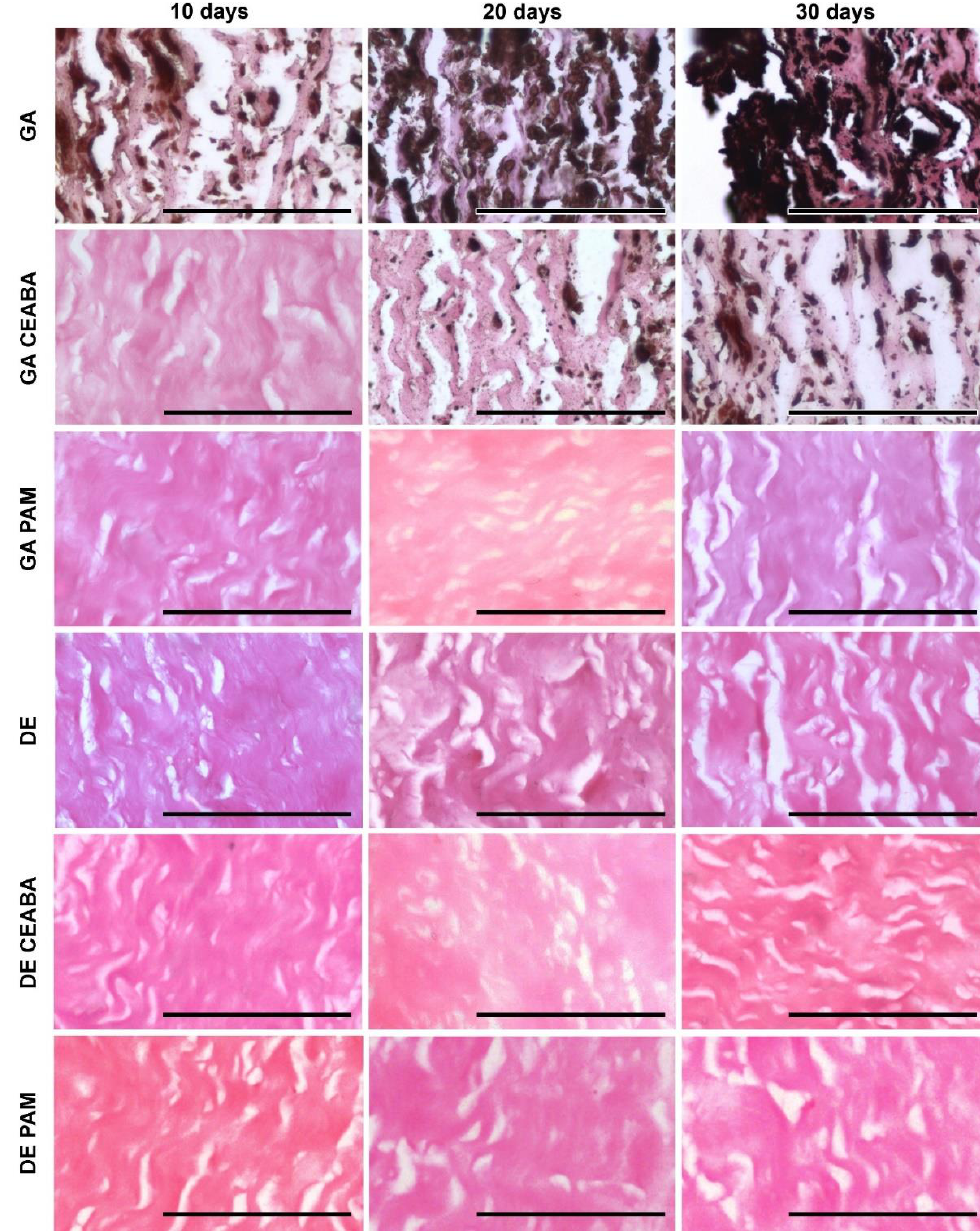
Figure 6. Calcium phosphate deposits in bovine pericardium implanted subcutaneously in rats, as visualized by von Kossa staining. Calcium phosphates were associated with collagen fibers in GA- and (GA + CEABA)-treated samples. All DE- and (GA + PAM)-treated samples were free of calcific deposits up to 30 days after implantation. Scale bars: 100 μm.